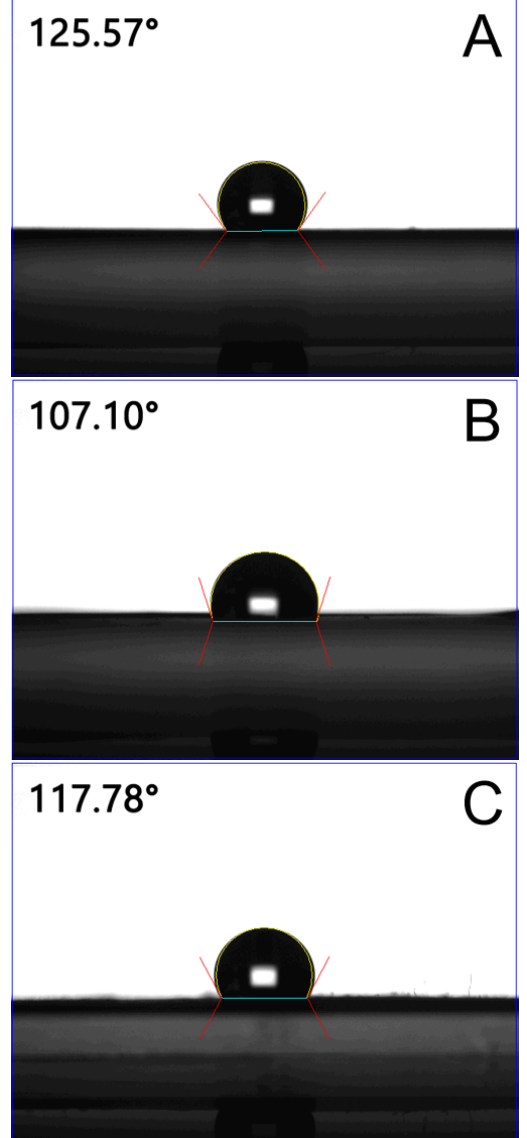
Figure 2. Water contact angles of: ( A ) pristine PLGA, ( B ) fluconazole-loaded nanofibers, and ( C ) vancomycin/ceftazidime-loaded nanofibers.